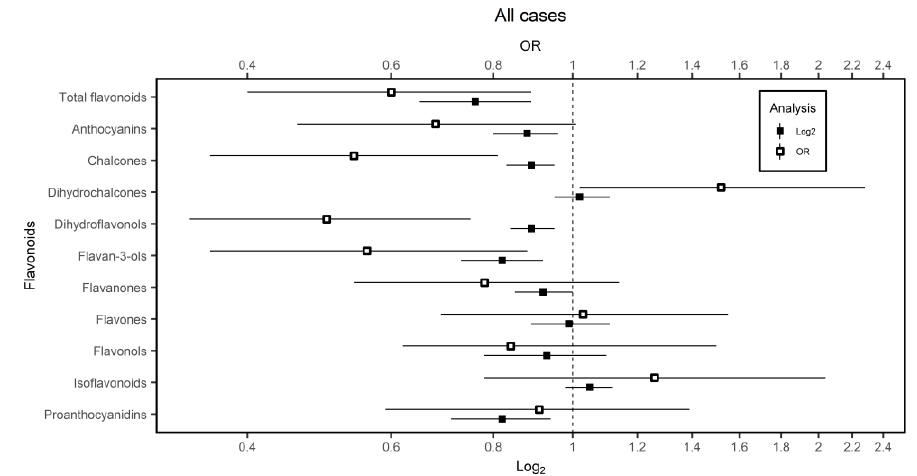
Figure Figure 2. Gastric cancer (GC) risk according to flavonoids intakes in the multi-case control (MCC-Spain) study.